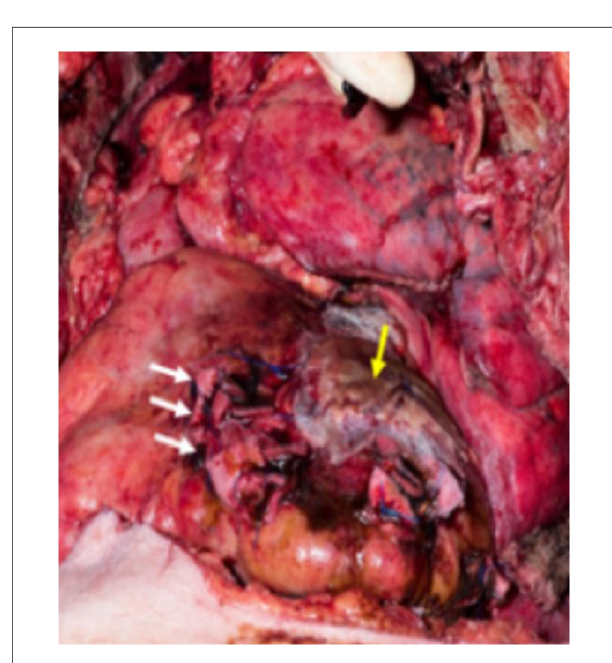
FIGURE 4 Intraoperative picture during repair of the right ventricular lesions (white arrows) and pericardial patch covering the left ventricular lesion (yellow